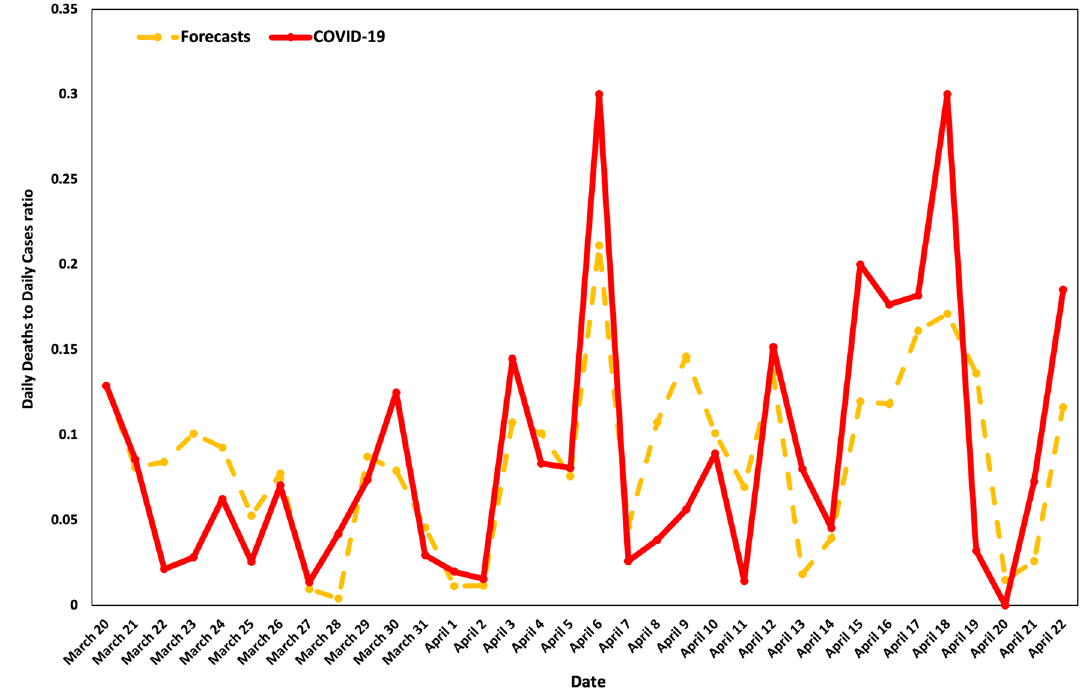
Figure 5. Official COVID-19 data vs.